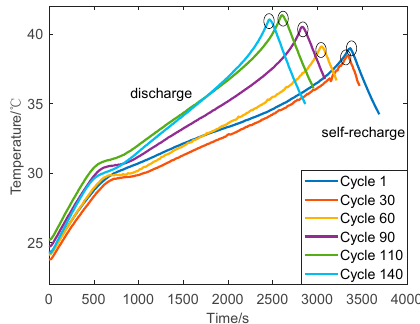
Figure 3. Discharging temperature curves of No. 5 with different cycles.